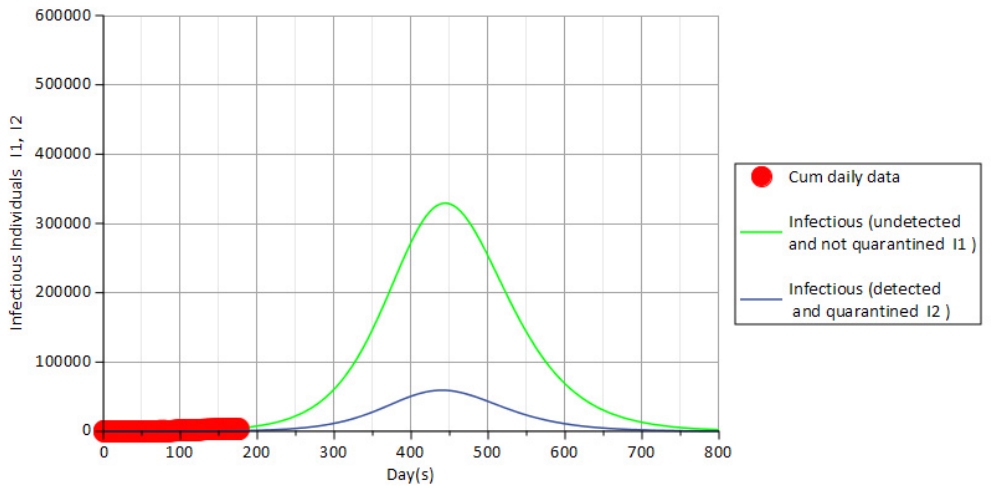
Figure 7. Effect of mass media value σ m = 0.60 with cumulative daily infectious individuals (red), I 1 ( t ) (green) and I 2 ( t ) (blue) using other parameters as in Table